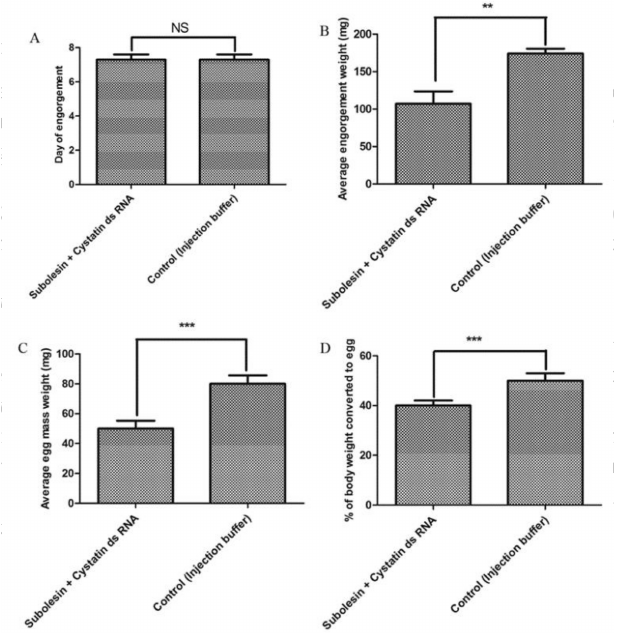
Figure 5. Knockdown effects of subolesin + cystatin ds RNA on tick engorgement and reproduction. ( A ) Average day of engorgement; ( B ) average engorgement weight; ( C ) average egg mass; and ( D ) average egg conversion ratio data were compared between subolesin + cystatin ds RNA and the control group injected with injection buffer. The asterisk (*) denotes a significant difference compared with the control group as determined by a Student’s t -test (** p < 0.002; *** p < 0.001). NS means not